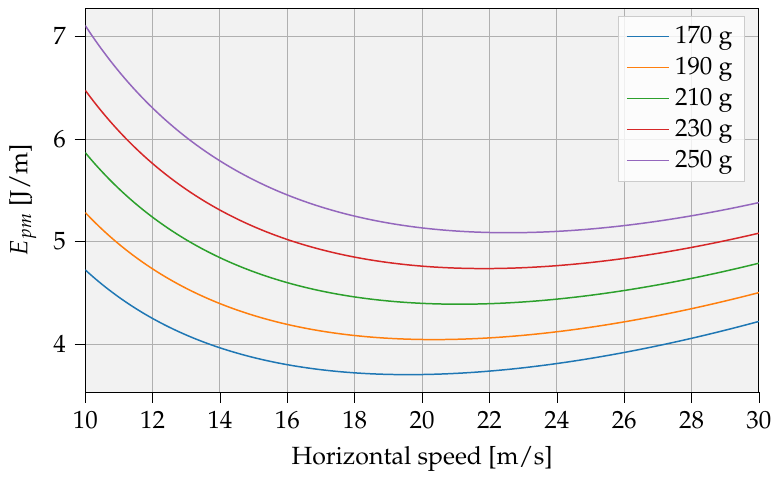
Figure 5. Energy per meter related to flight forward